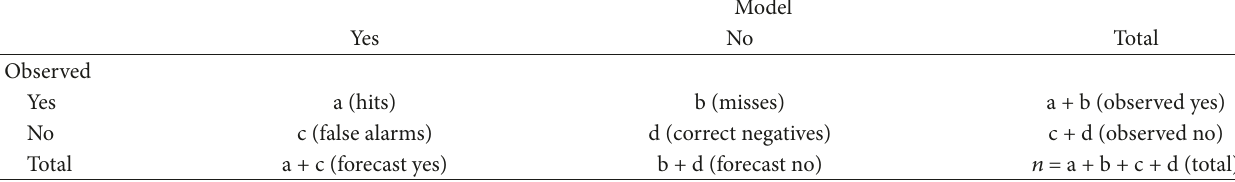
1.36 to 2.75. Categorical association attained by ECMWF is 0.39, EM is 0.42, SSE is 0.48, and BLUE is 0.45. In case of ETS, ECMWF attained 0.27. The ETS for EM is 0.28, SSE is 0.18, and BLUE is 0.29. BIAS is reduced to 0.35 in case of ECMWF, 0.15 for EM, and 0.05 for SSE and